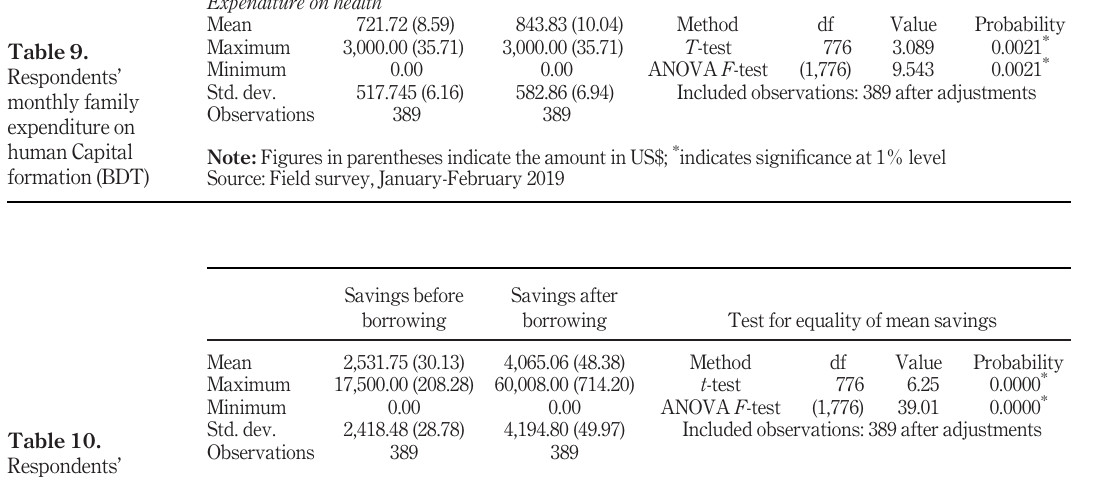
monthly family savings (BDT)